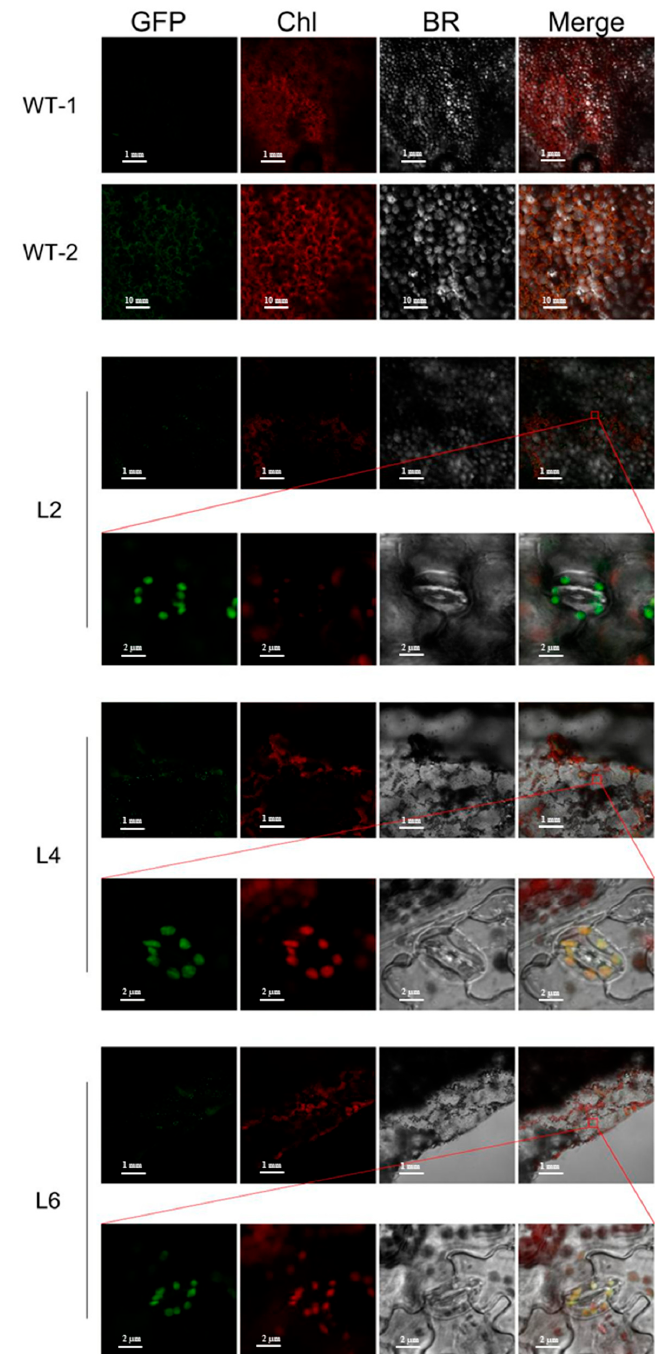
Figure 5. Subcellular localization of OE- TaPsb28 in transgenic Arabidopsis lines. GFP: yellow fluores- cent protein; Chl: chloroplast self-luminescence; BR: bright field.